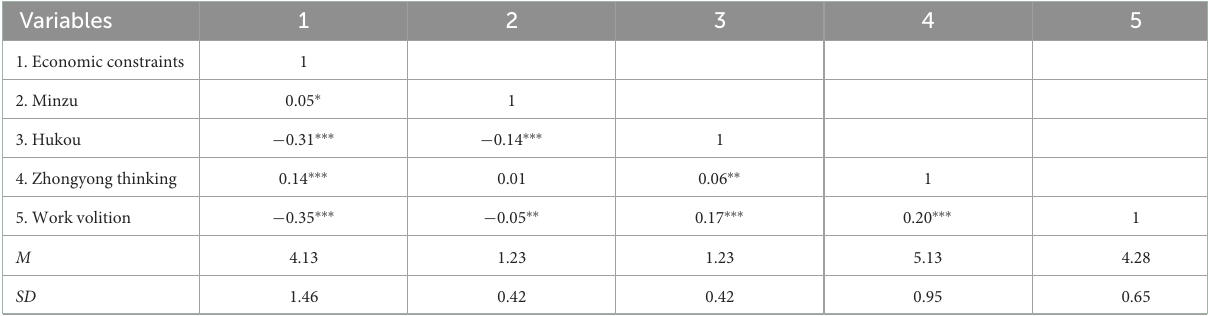
TABLE 1 Descriptive statistics and correlations.